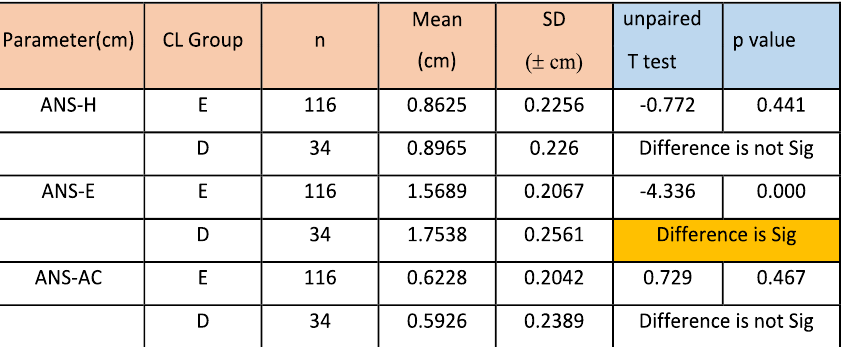
Table 4 Comparison of ultrasonographic parameters with the Cormack-Lehane